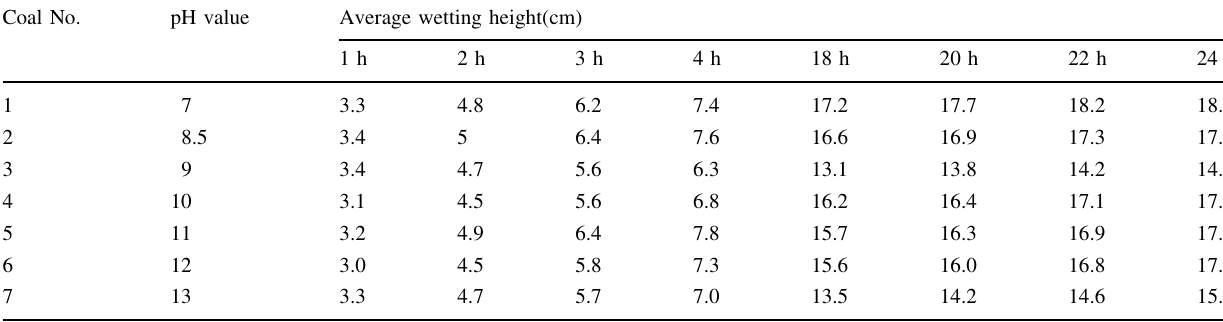
Table 3 Pulverized coal’s average wetting height in solutions with different pH values Coal